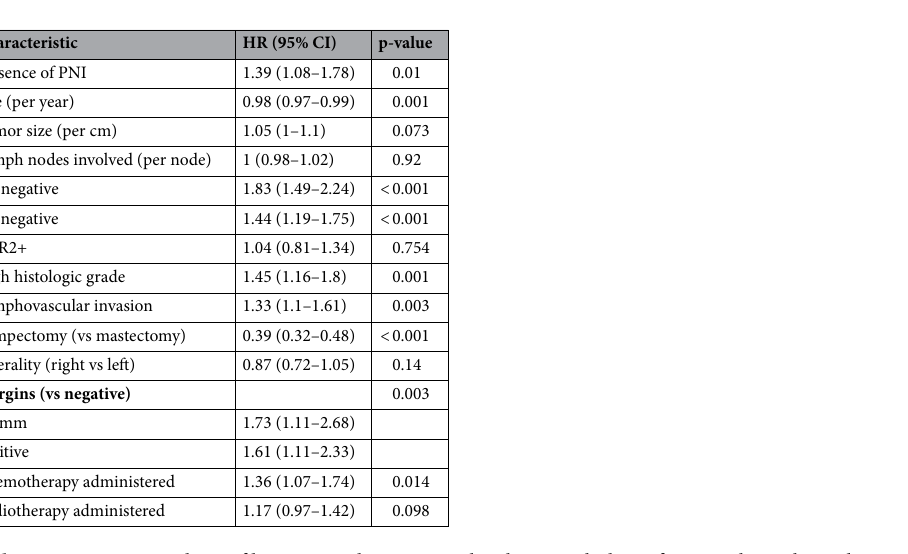
Table 2. Univariate analysis of locoregional recurrence by clinicopathologic features throughout the overall cohort.